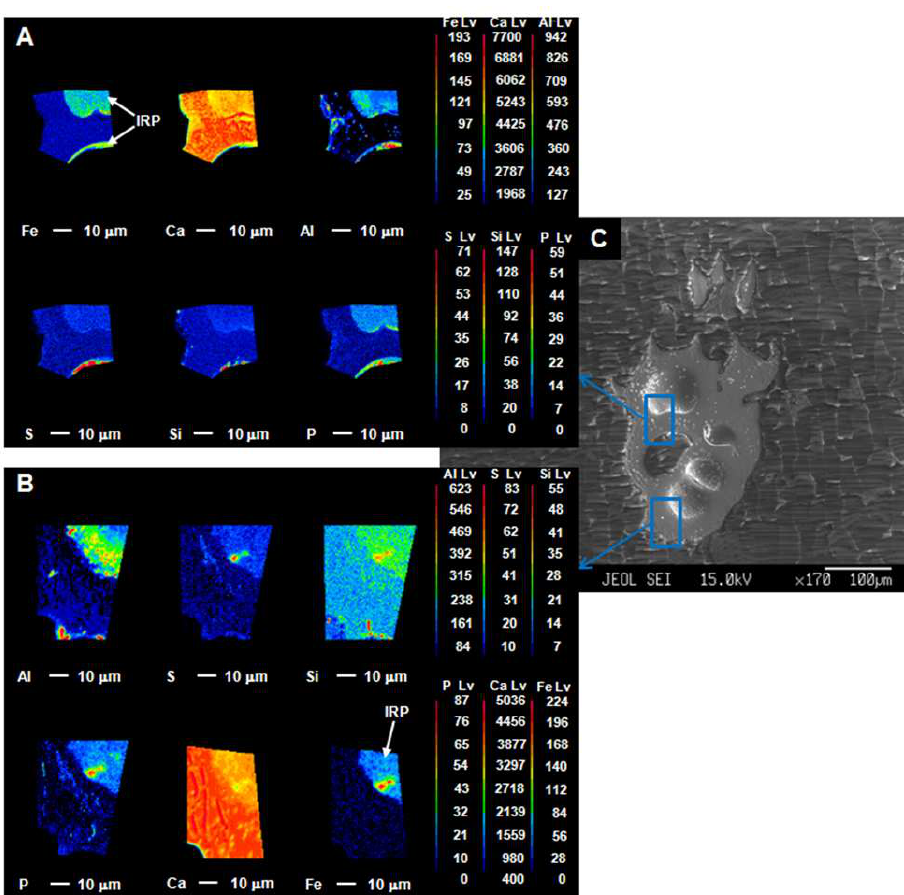
Fig. 3. EMP elemental mappings (A, B) and secondary electron image (C) for an Uvigerina peregrina specimen from 579m water depth (M77-1-487/MUC-39) on an exposed section of the foraminiferal test. Distribution of Ca, Mg, Fe, Ba, Mn, Al, S, Si and P in the foraminiferal test. All intensity values are expressed in counts per second (cps) as shown in the color bars. IRP: Fe rich phase at inner test surface.